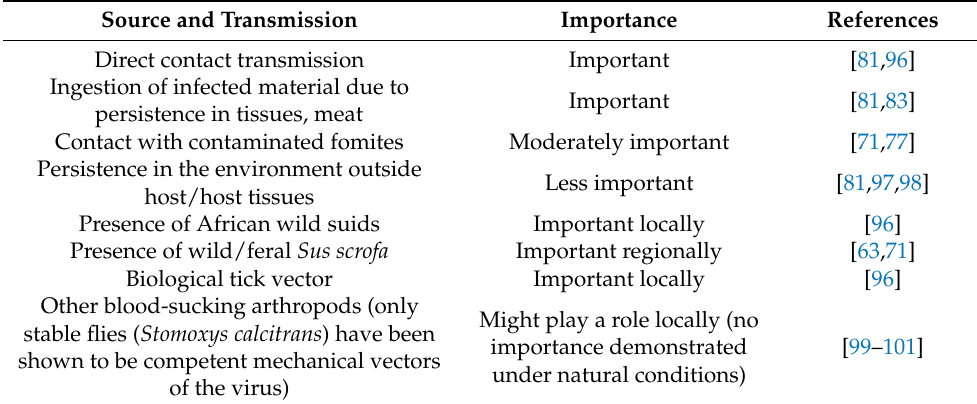
Table 1. Determinants of biosecurity measures for African swine fever. Source and